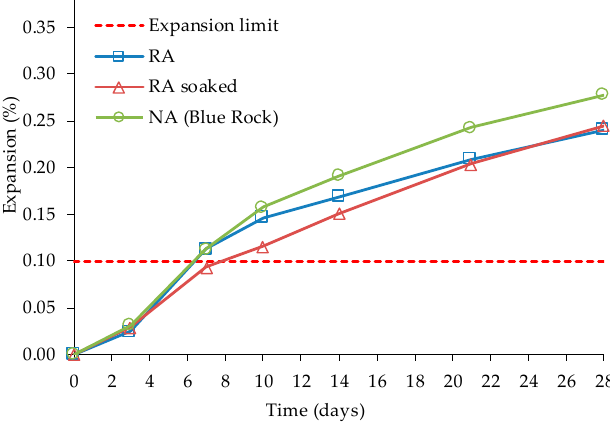
Figure 6. Expansion of saturated and unsaturated NA and RA in the ASTM C 1260 test, adapted from [78].